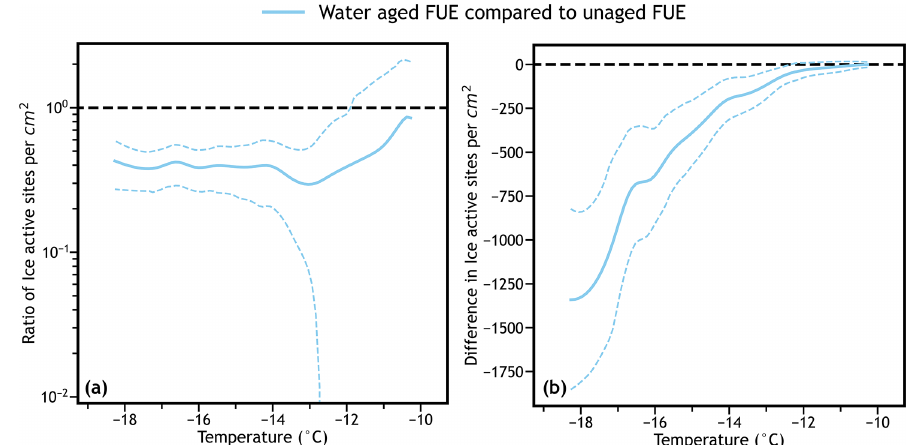
Figure 6. Comparison of the water aged n s spectrum to the unaged n s spectrum (a) by dividing and (b) by subtracting. The dotted line appears at (cid:49)n s = 1 in (a) and at (cid:49)n s = 0 in (b) , signifying no difference between the two spectra. Confidence bands are calculated us- ing interpolated tskew bootstrapped ratio/difference simulations as discussed above. Based on the confidence bands, there is a statistically significant difference between the water aged and unaged ash spectra for temperatures < − 12 ◦ C for both plots, and the magnitude of this difference is available as a function of